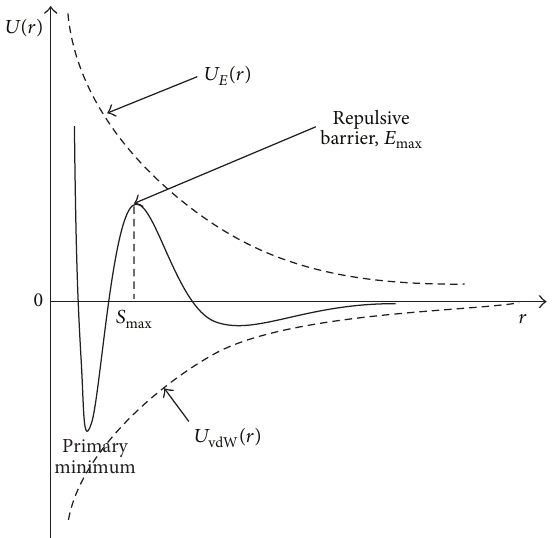
Figure 3: The competition between the electrostatic repulsion, (𝑟) , and the van der Waals attraction, 𝑈 (𝑟) , leads to the so- 𝑈 𝐸 vdW called DLVO interaction (solid line), which develops a repulsive at the position 𝑆 . Adapted from barrier of height 𝐸 max max